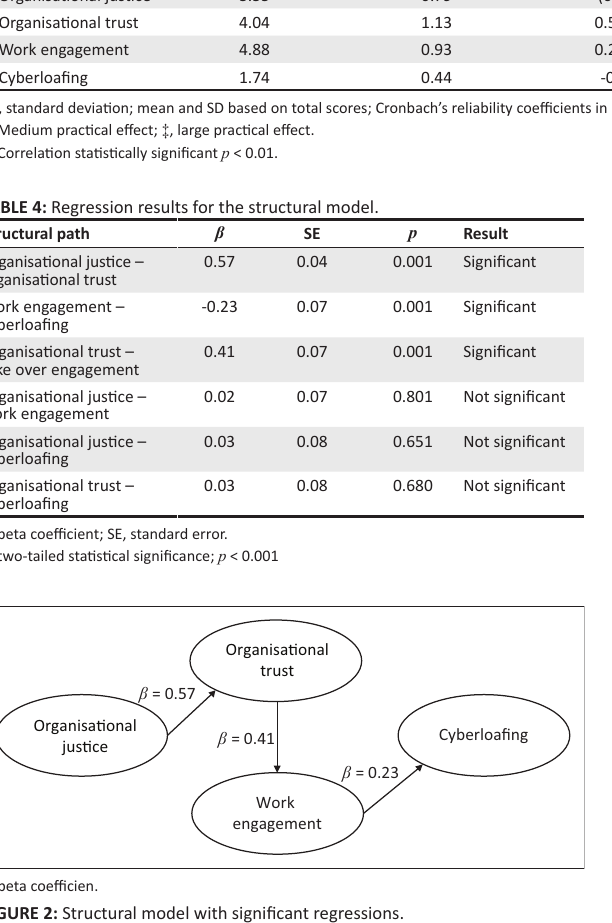
FIGURE 2: Structural model with significant regressions.